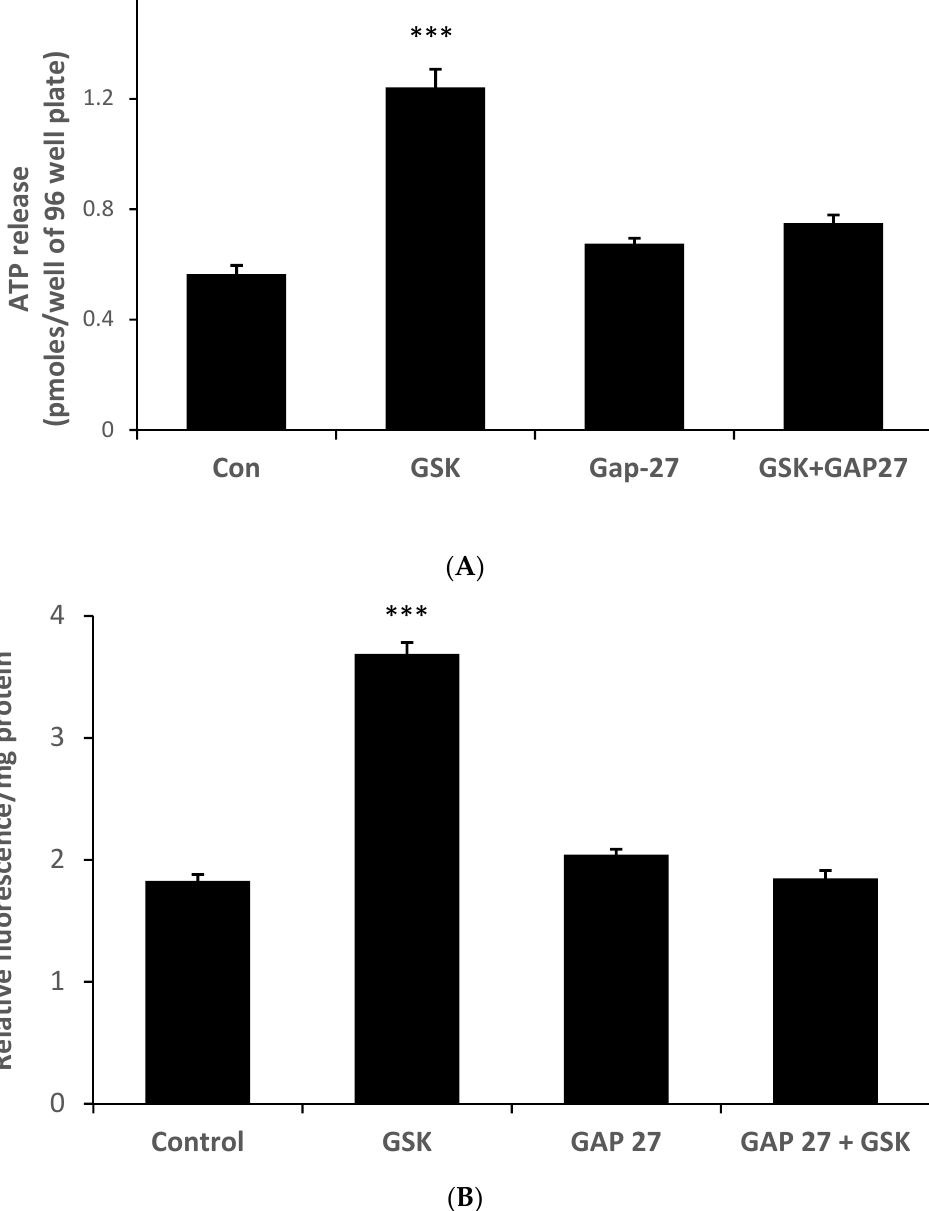
Figure 6. The connexin mimetic peptide Gap 27 prevents ATP release and PI uptake responses to TRPV4 activation by a selective agonist, GSK1016790A. The amount of ATP in the bathing medium ( A ) or cell PI fluorescence ( B ) was measured after exposing the monolayers of cultured NPE cells to GSK1016790A (10 nM) in the presence or absence of Gap 27 (200 µM) added 60 min beforehand. The data are the mean ± SE of results from six independent experiments. *** ( p < 0.001) indicates significant differences from